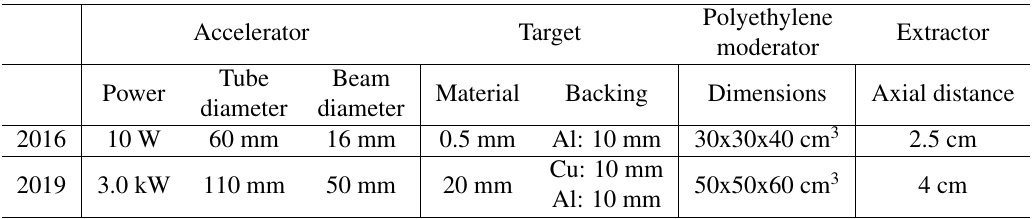
Table 1: Neutronic and thermal properties for di ff erent material foreseen as a target. The neutron yields are from [3]. Table 2: Main di ff erences between the 2016 and 2019 TMR experimental configurations performed at IPHI.